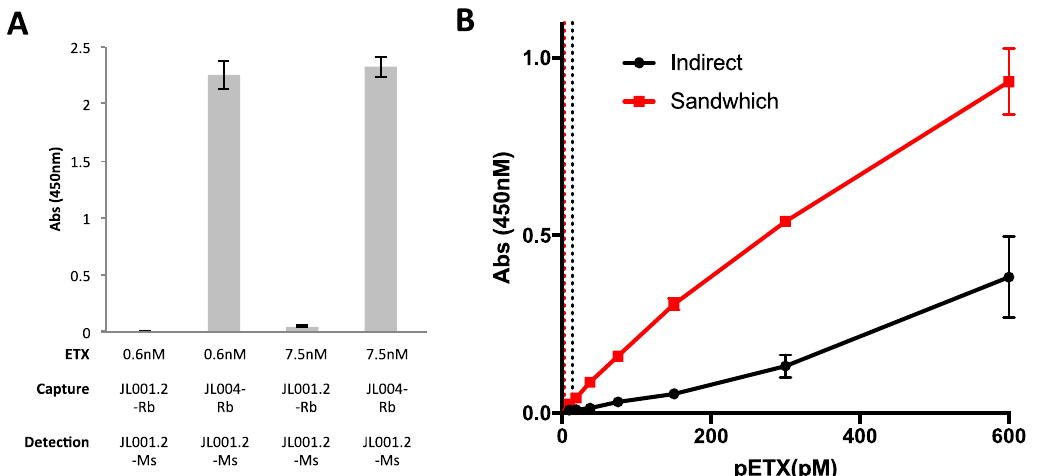
Figure 4. Detection of pETX via Sandwich ELISA. ( A ) To test possible capture antibodies, JL001.2 with the rabbit Fc regions (JL001.2-Rb) and JL004 with the rabbit Fc region (JL004-Rb) were coated on ELISA plates and incubated with 0.6 nM and 7.5 nM pETX. JL001.2 with the mouse Fc region (JL001.2-Ms) was used as the detection antibody. ( B ) Sensitivity of pETX detection using indirect ELISA (JL001.2-Rb) was compared to the sensitivity of the sandwich ELISA using JL004-Rb as capture antibody and JL001.2-Ms as the detection body. The sandwich ELISA was more sensitive than the indirect ELISA method. The limit of detection (LOD) for the sandwich ELISA (red-dotted line) was 2.65 pM and 13.68 pM for the indirect ELISA (black dotted line). Results are mean ± SD.